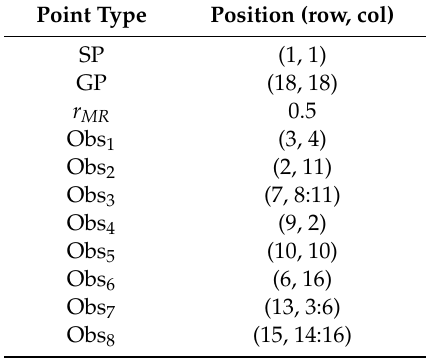
Table 1. Grid-based static environment 1 setting.